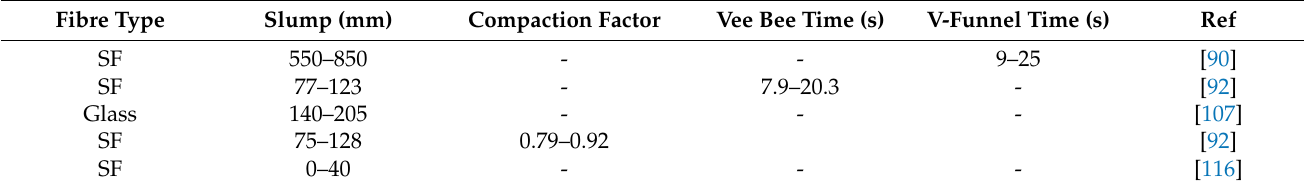
Table 5. Fresh concrete